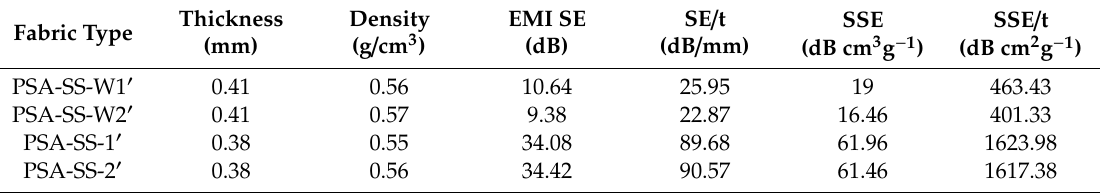
Table 2. The shielding e ff ectiveness per unit volume (SSE) and SSE / t of four types of fabrics. Fabric